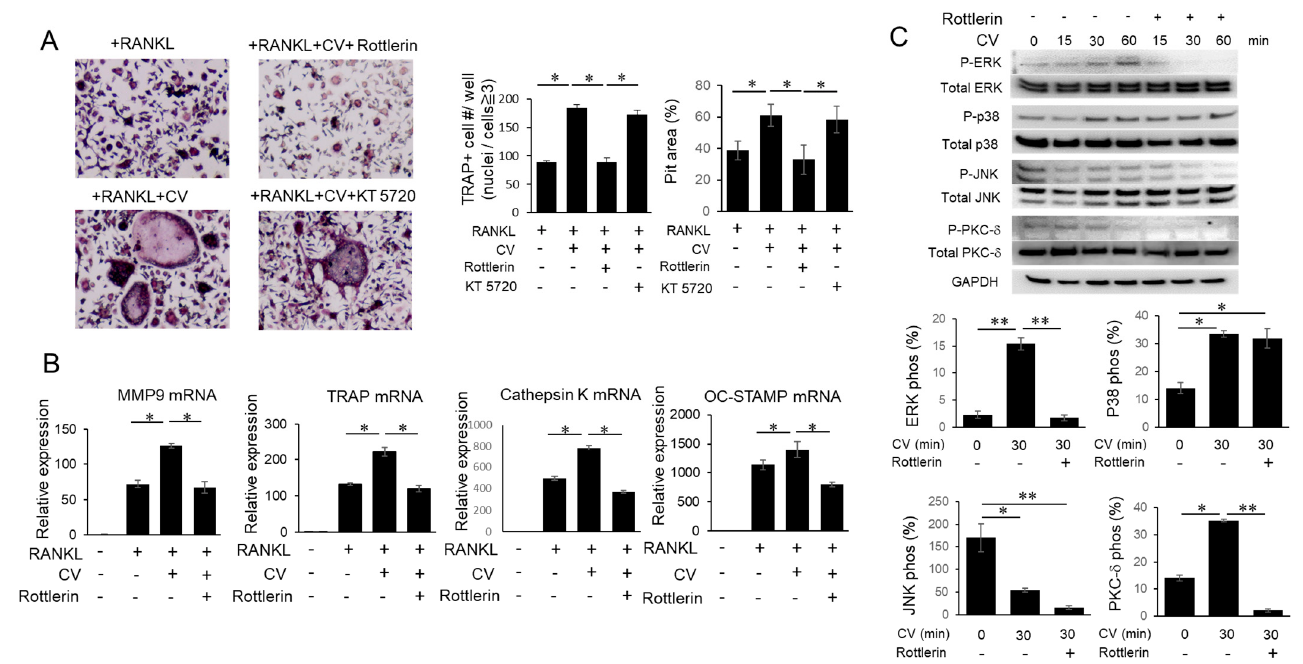
Figure 4. PKC- δ inhibitor can suppress CV-dependent elevated OC-genesis. Effect of PKC- δ inhibitor Rottlerin in comparison with PKA inhibitor KT5720 on the CV-dependent upregulation of OC-genesis was evaluated using mouse BM-derived OC precursors stimulated with M-CSF and RANKL. ( A ) OC precursors were stimulated with CV in the presence or absence of KT5720 (5 µM) or Rottlerin (5 µM) for 7 days with the addition of fresh medium every 3 days. TRAP staining and pit formation assays were performed. ( B ) Relative expression of MMP9, TRAP, Cathepsin K and OC-STAMP mRNAs in OC precursors was stimulated in the presence or absence of CV (10 ng/mL) with or without Rottlerin for 24 h. The relative fold changes of mRNA expression levels were deter- mined by qPCR (normalized to GAPDH mRNA levels). ( C ) Western blotting was performed on protein extracts from OC precursors stimulated with CV (10 ng/mL) with or without Rottlerin for 0, 15, 30, and 60 min. Total p38 MAPK , JNK, ERK and PKC- δ as well as phosphorylated counterparts were evaluated using the antibodies described in the Materials and Methods section. Densitometric analysis of phosphorylated p38 MAPK , JNK, ERK and PKC- δ signals is shown. All assays were per- formed in triplicate. Data represent the mean ± SD of three independent experiments. Results were presented as the means ± SD. * p < 0.05; ** p < 0.01. Scale bar: 100 µm. 3.5. Vimentin and CV Detected in Periodontitis is Induced in Mice The possible expression of CV in periodontitis was evaluated in mice induced with periodontitis by the attachment of a ligature to the maxillary second molar. According to the immunohistochemistry of the decalcified alveolar bone isolated from mice euthanized on day 7, vimentin-positive mononuclear cells were detected in the tissue of mice induced with periodontitis, but not in the tissue collected from healthy control mice (Figure 5A). The level of vimentin and CV in the gingival crevicular fluid (GCF) collected on day 7 significantly increased in the group induced with periodontitis compared with that of the periodontally healthy control group (Figure 5B). Finally, an IgG antibody response to CV and vimentin was not detected in the serum samples collected from the mice on day 7 (Figure 5C).